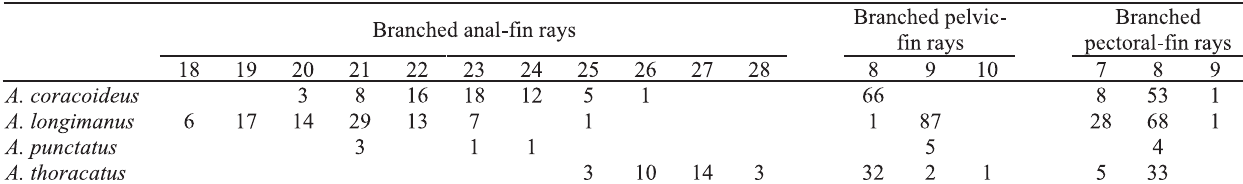
Table 1. Numbers of specimens of species of Auchenipterichthys with cited number of branched anal-, pelvic- and pectoral- fin